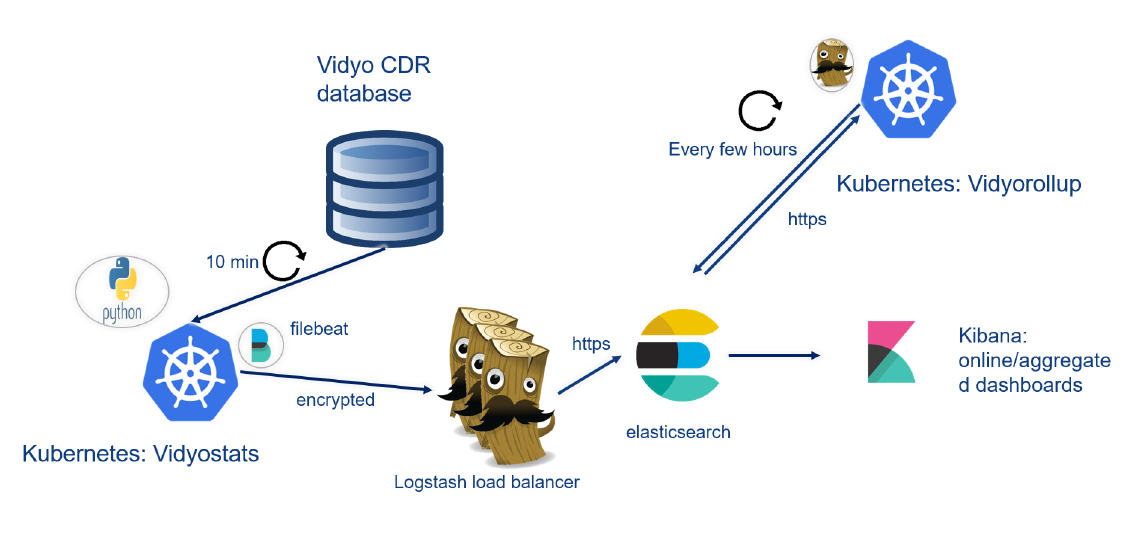
Figure 2. Vidyo stats gathering architecture.